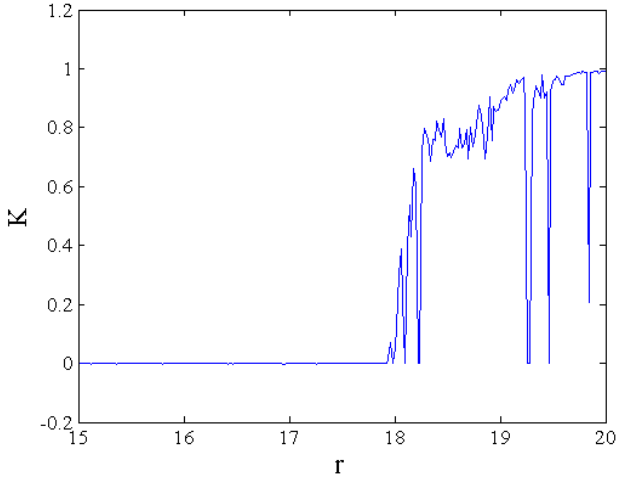
Figure 7. Asymptotic growth rate K of the fractional-order map with regard to r.